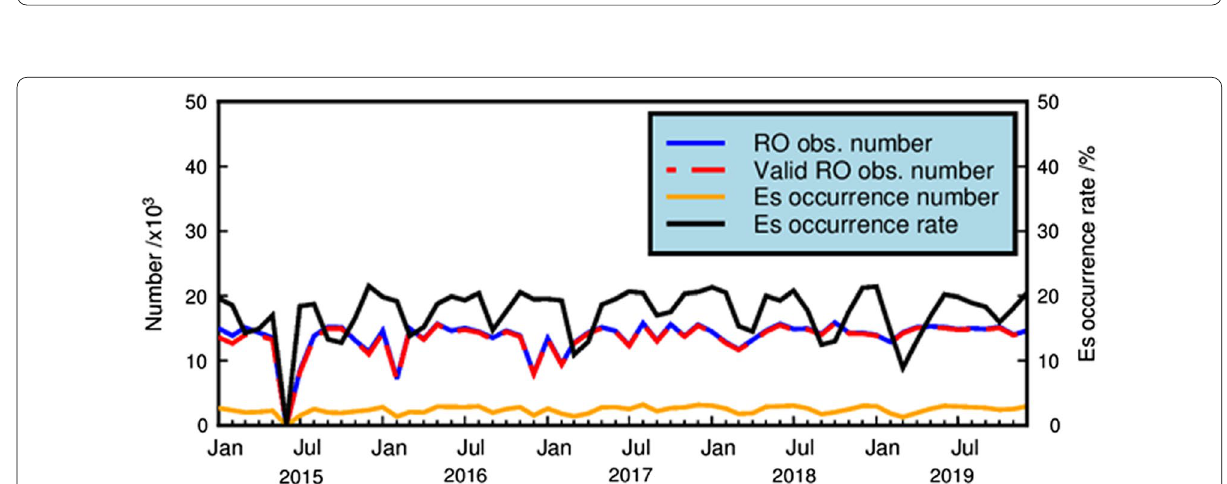
Fig. 3 Monthly variations of the number of all FY-3C RO measurements (in blue), the number of RO measurements valid for Es-layer detection (in red), the number of RO observations detected with Es layers (in yellow), and the Es occurrence rates (in black, right y-axis), during 2015 to 2019